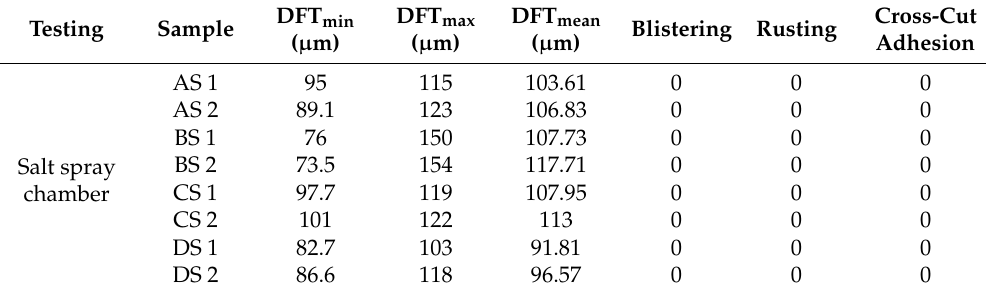
Table 3. Assessment of the coating protection properties after 240 h in the salt spray chamber.